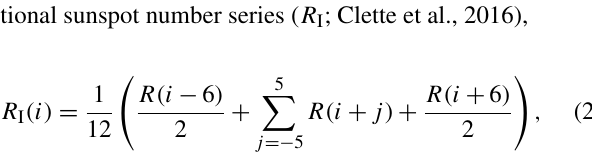
against aa H max